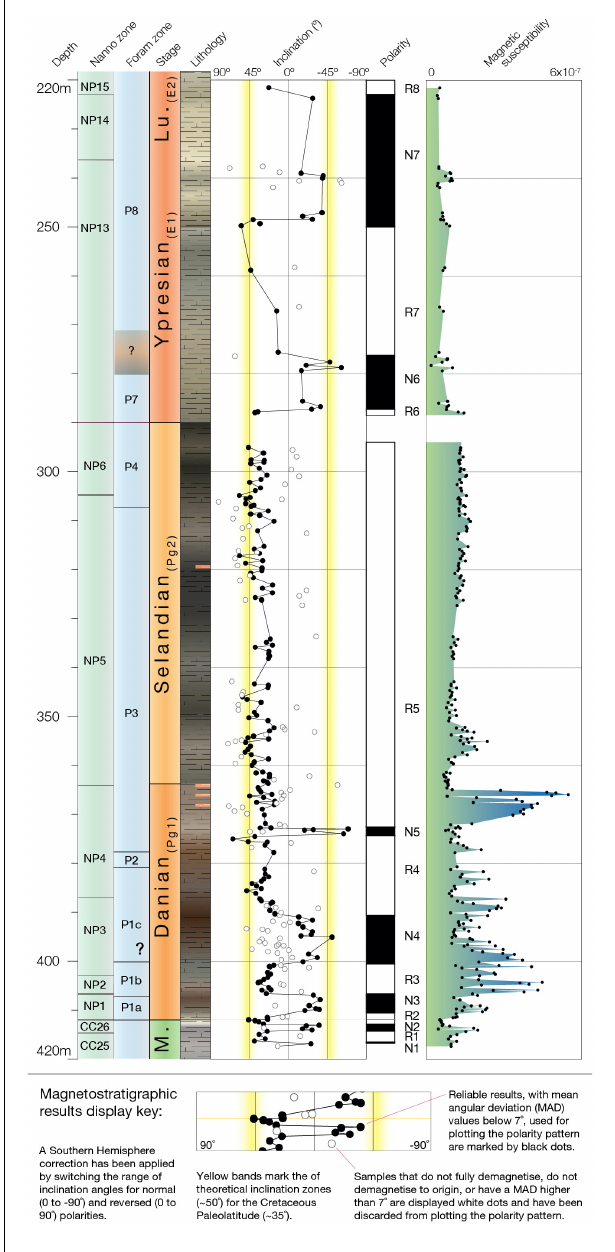
FIGURE 4 | Magnetostratigraphy and magnetic susceptibility results from DSDP Site 356.